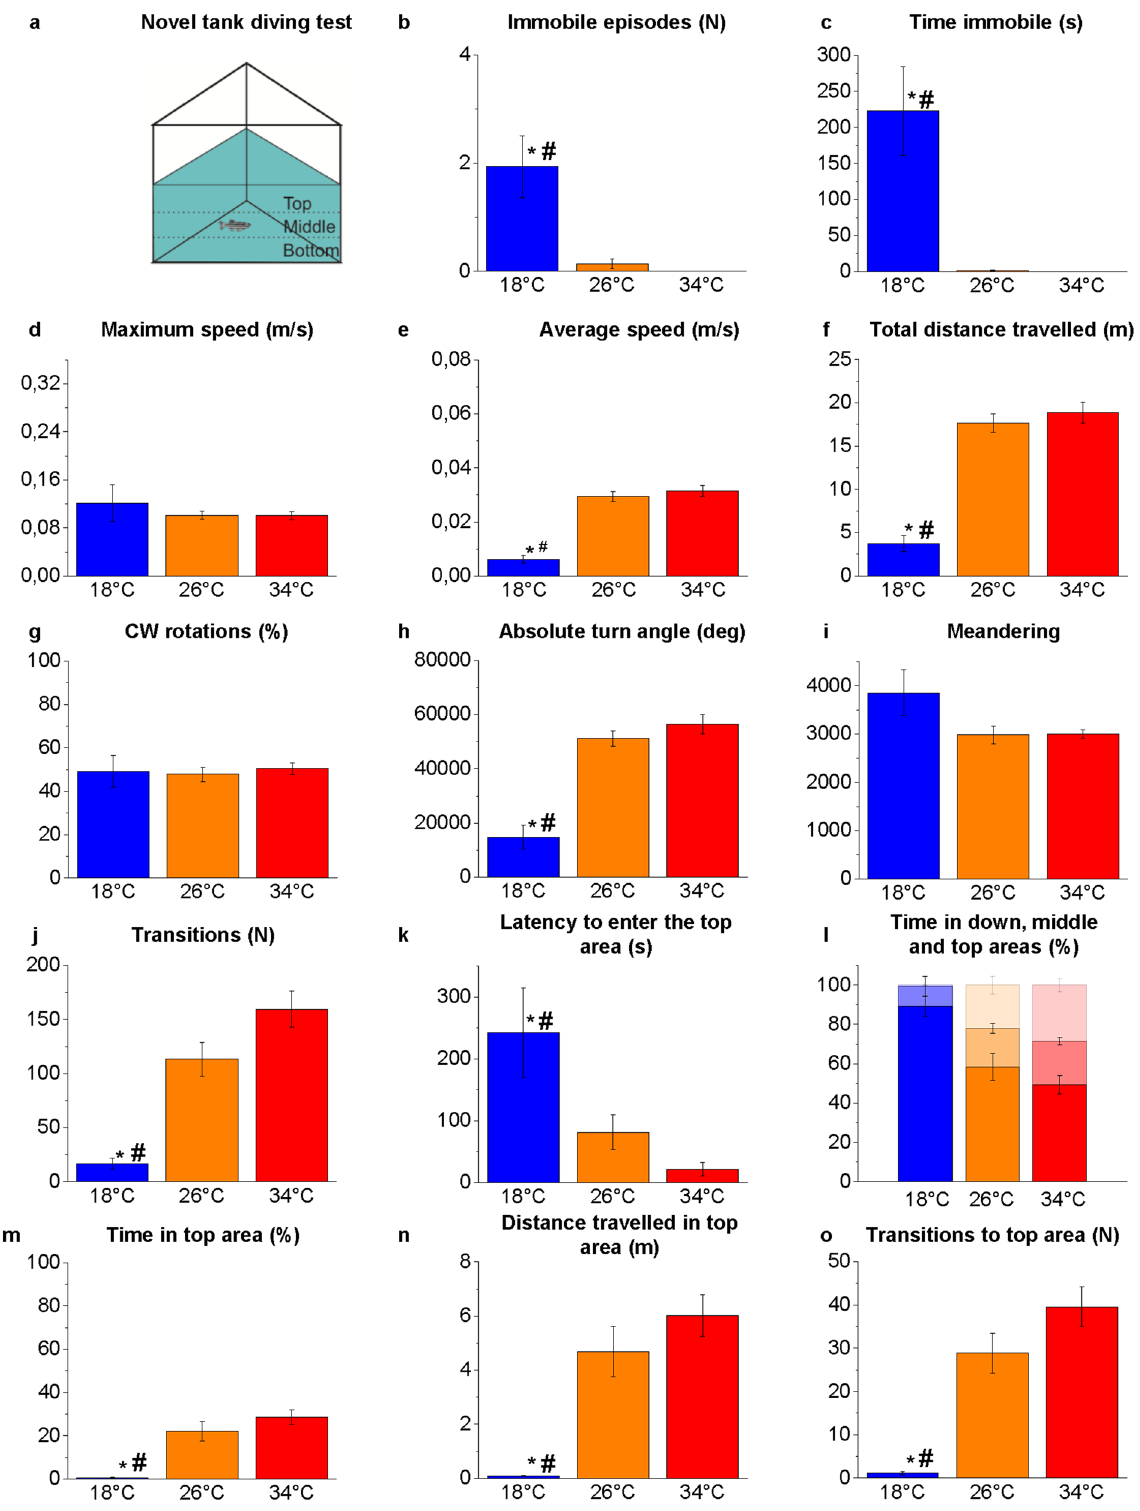
Figure 1. Novel environment exploration behaviour in the NTT. Schematic representation outlining the experimental design ( a ). Immobile episodes ( b ), time immobile ( c ), maximum speed ( d ), average speed ( e ), total distance travelled ( f ), clockwise (CW) rotations expressed as the percentage of total rotations ( g ), absolute turn angle ( h ), meandering ( i ), transitions among areas ( j ), latency to enter the top area ( k ), time spent in the three vertical virtual areas of the tank ( l ), time spent in the top area expressed as a percentage of the total time ( m ), distance travelled in the top area ( n ) and number of transitions to the top area ( o ). The data are expressed as means ± S.E.M. and analysed by one-way ANOVA with Bonferroni post hoc correction. P ≤ 0.05, * 18 °C versus 26 °C; # 18 °C versus 34 °C and $ 34 °C versus 26 °C. P values are reported in Table S2. N =